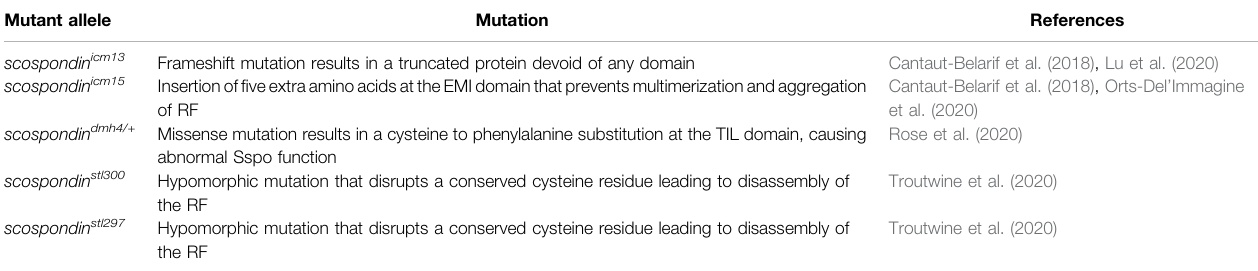
TABLE 1 | Molecular lesions in the zebra fi sh scospondin ( sspo )